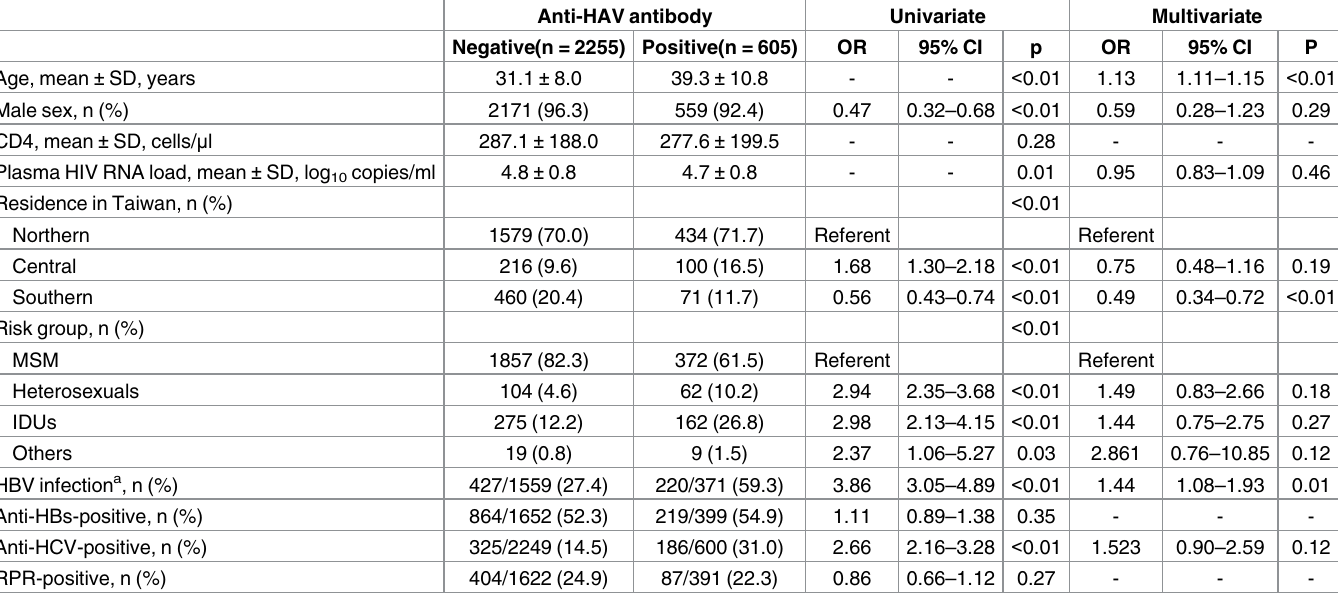
Table 2. Factors associated with positive anti-HAV antibody in the